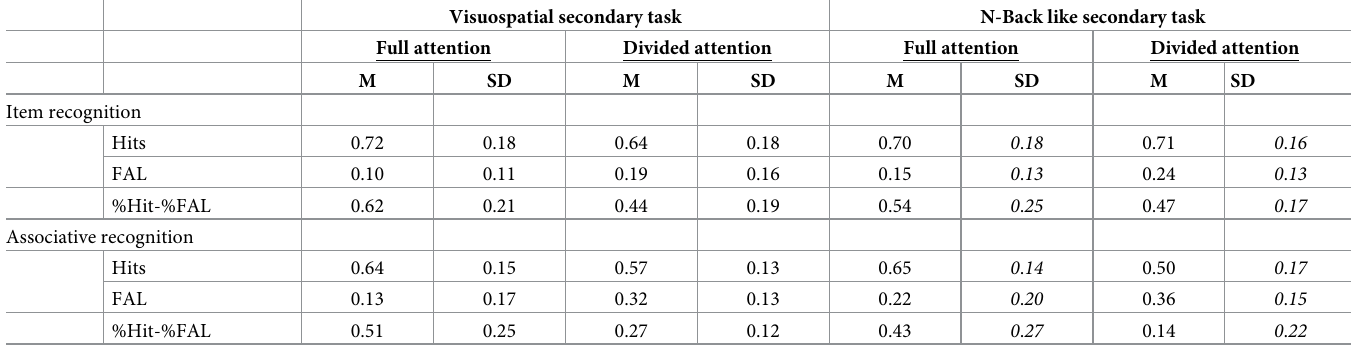
Table 2. Memory performance; proportion of hits and false alarms (FAL) in full- and divided-attention conditions for the two experimental task-groups.